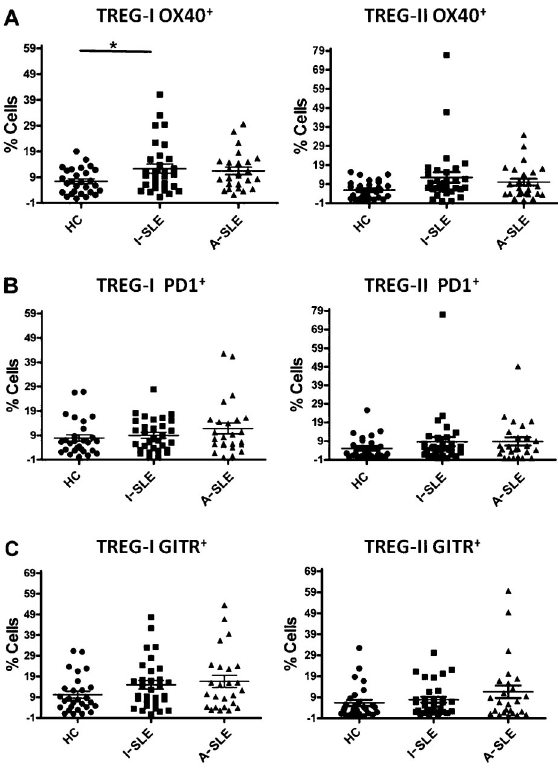
Figure 5. Analysis of the frequency of TREG-I (CD25 + CD127 low/Ø FoxP3 + ) and TREG-II (CD25 high CD127 low/Ø FoxP3 + ) cells expressing OX40 ( A ), PD1 ( B ), and GITR ( C ) in patients with active SLE (A-SLE), inactive SLE (I-SLE), and healthy controls (HC). The relative frequency of OX40 + , PD1 + , and GITR + cells was calculated over total TREG-I and TREG-II, respectively. Horizontal bars indicate means and standard deviation, respec- tively. *P , 0.05 (Kruskal-Wallis